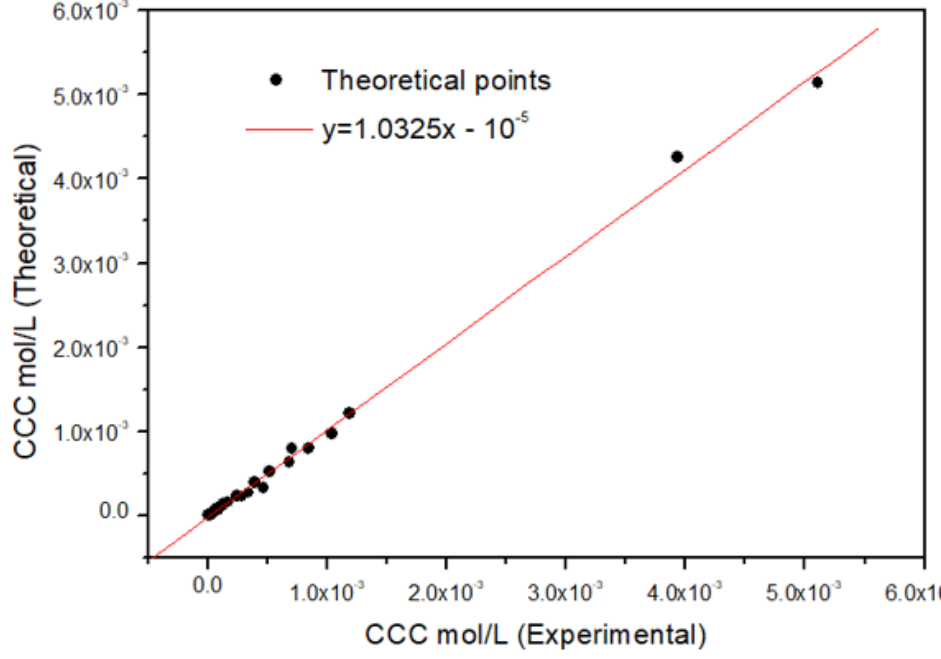
Figure 9. Theoretical versus experimental values of the critical coalescence concentration (CCC).